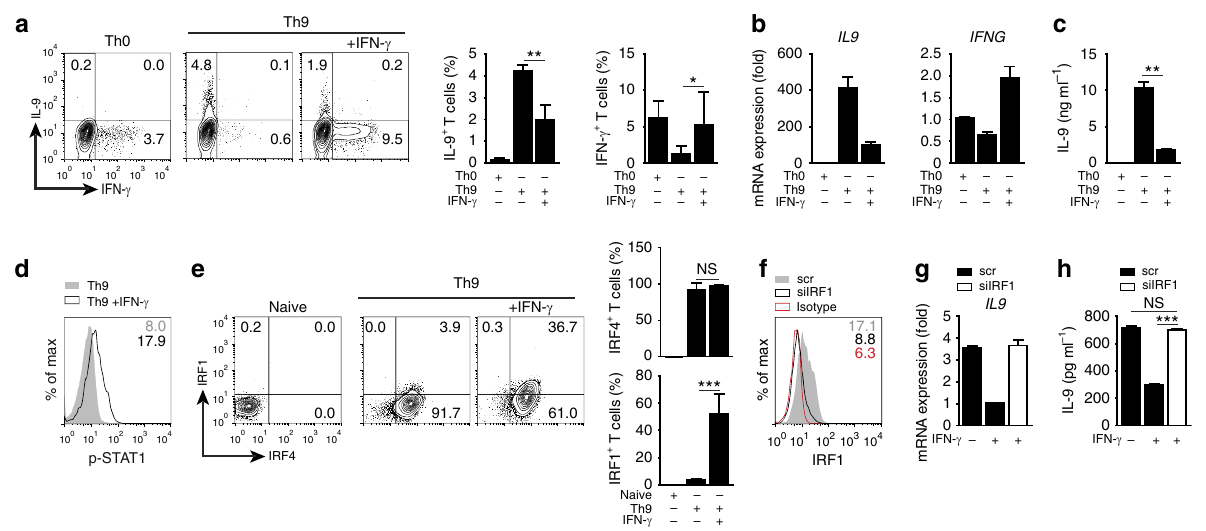
Figure 6 | IFN- c /STAT1-induced IRF1 suppresses IL-9 production in human Th9 cells. Naive CD4 þ CD25 (cid:2) CD45RA þ CD45RO (cid:2) T cells were isolated from human PBMCs and cultured under Th0 or Th9 conditions in the presence or absence of human IFN- g as indicated. ( a ) Intracellular staining for IL-9 and IFN- g after 3 days of culture (bars to the right give mean ± s.d. of three independent experiments). ( b ) Expression of IL9 and IFNG mRNA on day 2 in Th0 and Th9 cells; results were normalized to 18S and are presented relative to Th0 cells. ( c ) ELISA of IL-9 in supernatants of Th0 and Th9 cultures after 3 days. ( d ) Phospho-flow for p-STAT1 in Th9 cells with or without IFN- g treatment, day 2 of culture (values show mean fluoresence intensity). ( e ) Intracellular staining for IRF1 and IRF4, day 2 of culture (bars to the right give mean ± s.d. of three independent experiments). ( f – h ) Human naive CD4 þ CD25 (cid:2) CD45RA þ CD45RO (cid:2) T cells were activated under Th0 condition for 16h, then transfected with scrambled (scr) or IRF1-specific siRNA (siIRF1) and then cultured for further 72h under Th9 conditions with/without IFN- g . ( f ) Intracellular staining of IRF1 in scr- or siIRF1-transfected cells 24h post transfection upon culture under Th9 conditions with IFN- g . ( g ) Expression of IL9 mRNA in transfected cells at 48h post transfection; results were normalized to 18S and are presented relative to Th9 cells treated with scr siRNA and IFN- g . ( h ) ELISA of IL-9 in supernatants of transfected cells 72h post transfection. ( a – h ) Data are representative of three independent experiments with different donors; * P o 0.05, ** P o 0.005, *** P o 0.001 (two-tailed Student’s t